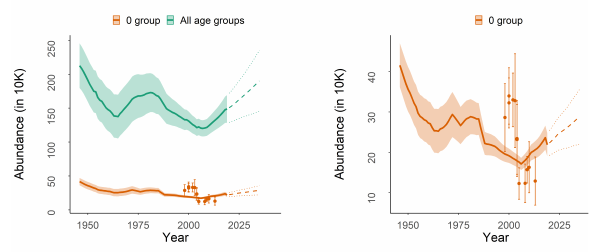
Figure 2. For harp seals breeding in the Barents Sea/White Sea, the modelled total population (left panel) and the model fit to the estimated pup production (right panel). Full lines show historical trajectory, dashed lines show the future predictions, and shaded area shows the 95% confidence